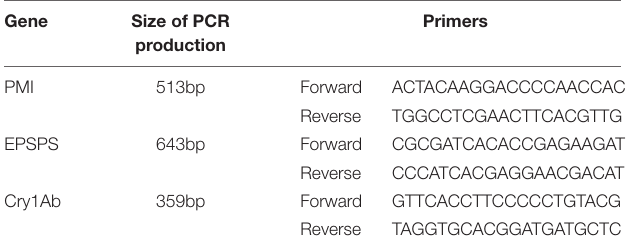
TABLE 1 | Primer sequences for PCR